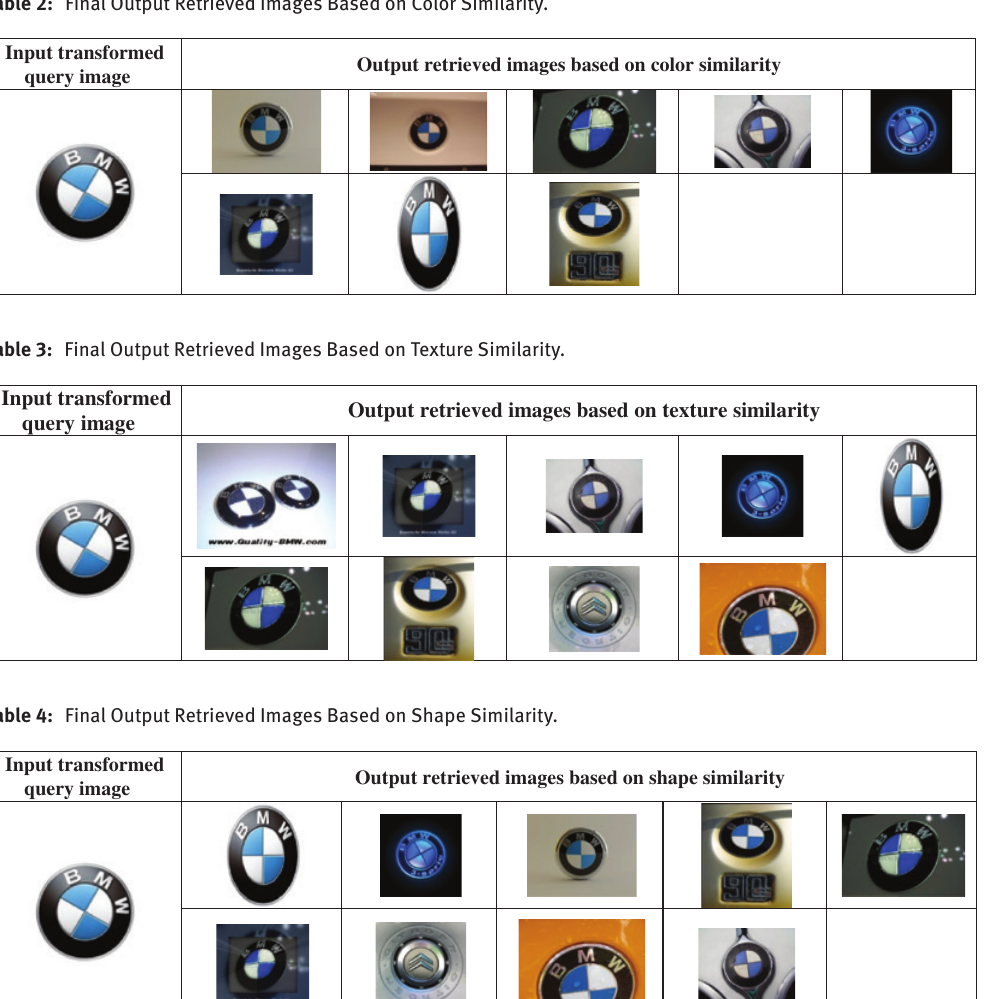
Table 2: Final Output Retrieved Images Based on Color